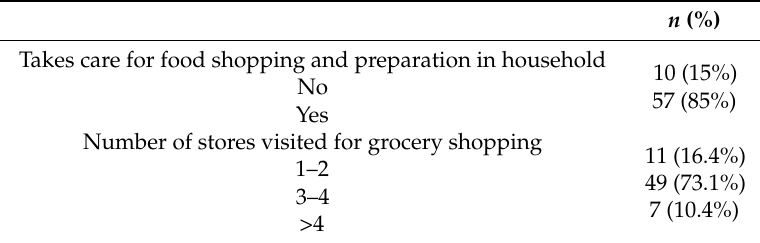
Table 4. Food behaviors measured with NEMS-P (n = 67